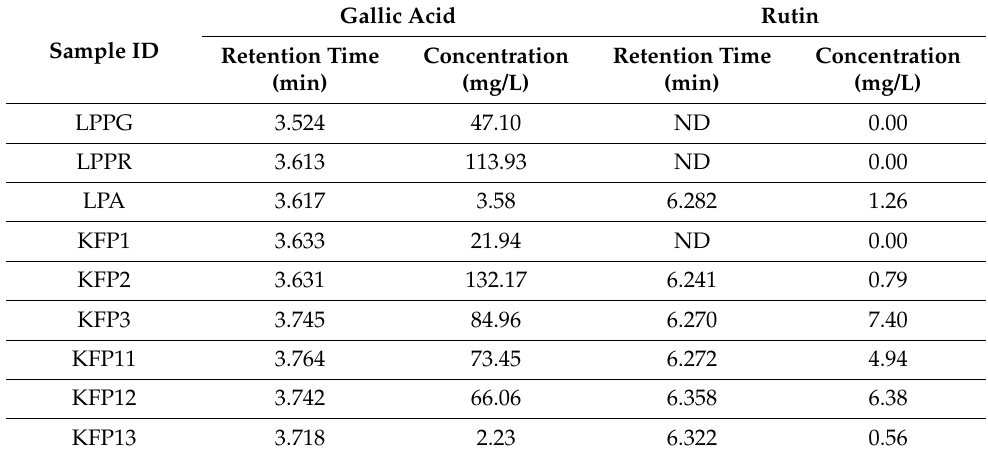
Table 2. Concentration (mg/L) of gallic acid and rutin in Labisia pumila leaf extract and